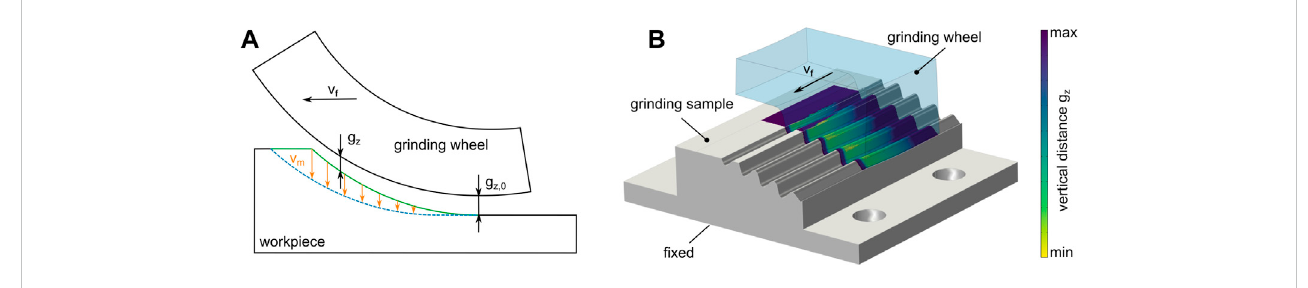
FIGURE 7 (A) Schematic representation of the distance-based simulation of material removal and (B) associated FE model with distance g z (Grimmert and Wiederkehr,